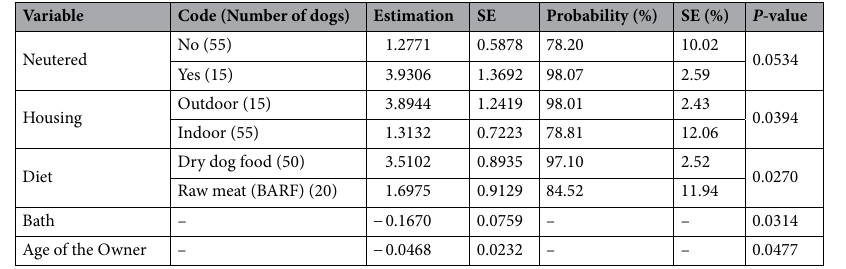
Table1. Estimated parameters for each variable.